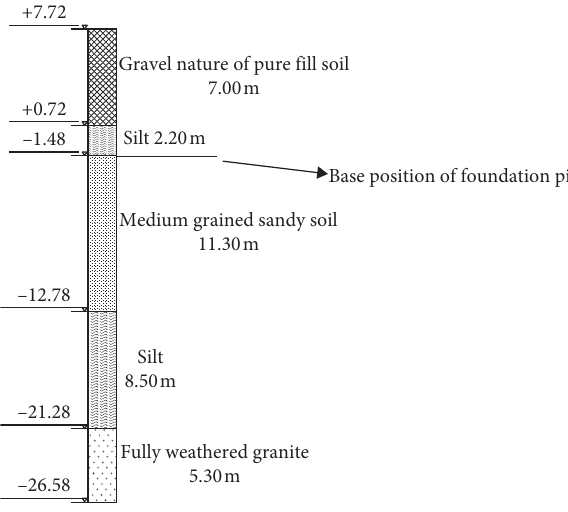
Figure 4: Geological profile around the foundation pit.